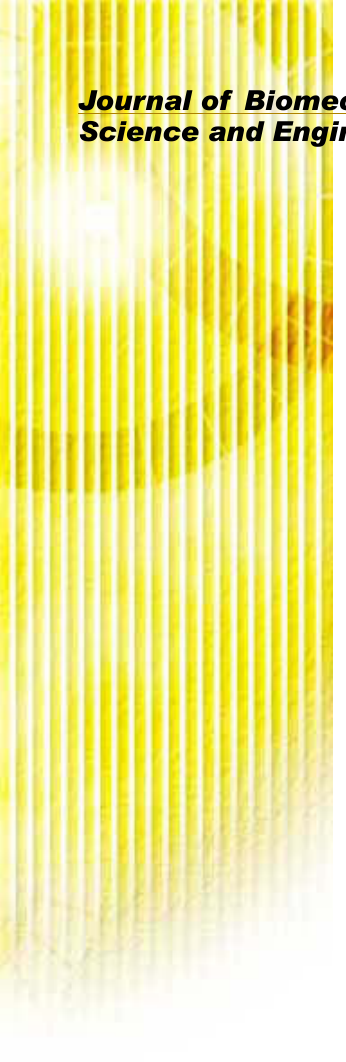
Fig. 3 The relationship between the peak value of the resistance torque and angular velocity for modes 1 to 4.